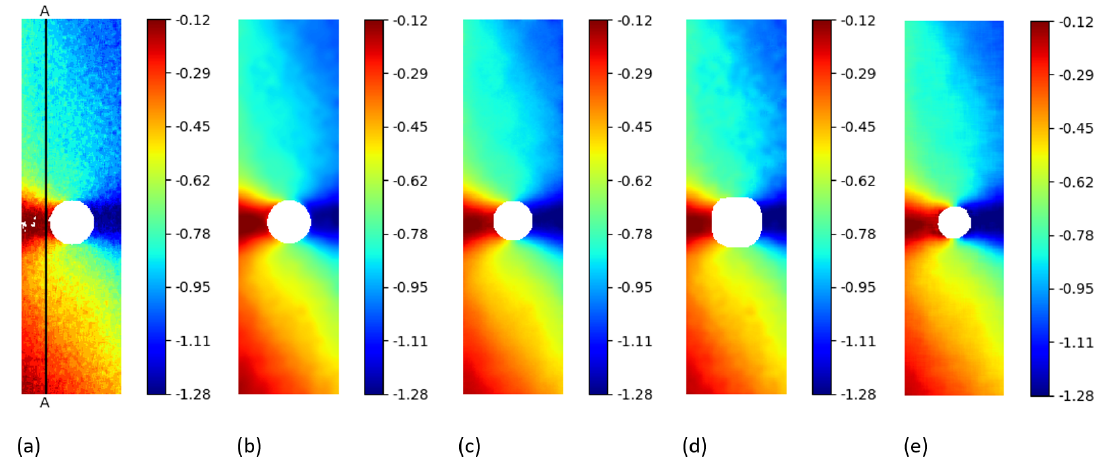
Figure 5. u displacements (px) for the “plate hole” sample from SEM DIC challenge obtained from DIC technique. ( a ) py2DIC raw results ( b ) py2DIC smoothed results using Gaussian filter ( c ) Ncorr results ( d ) Vic-2D results ( e ) DICe